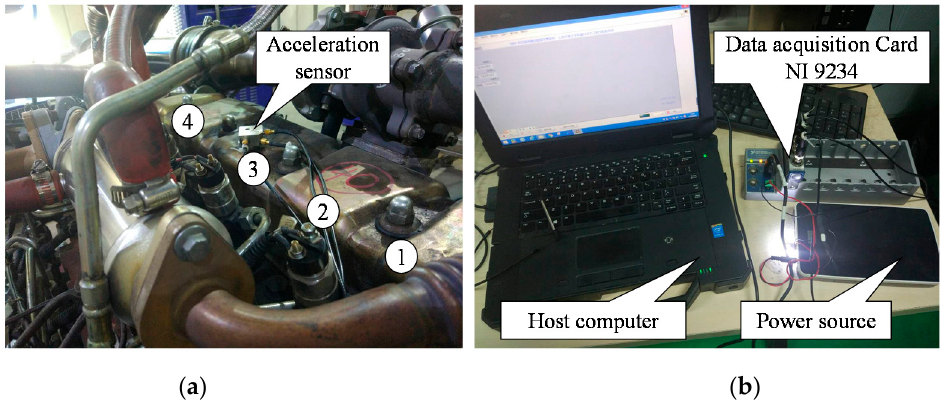
Figure 3. The test rig used for diesel engine misfire assessment: ( a ) Installation of the vibration sensor; ( b ) Data acquisition system.